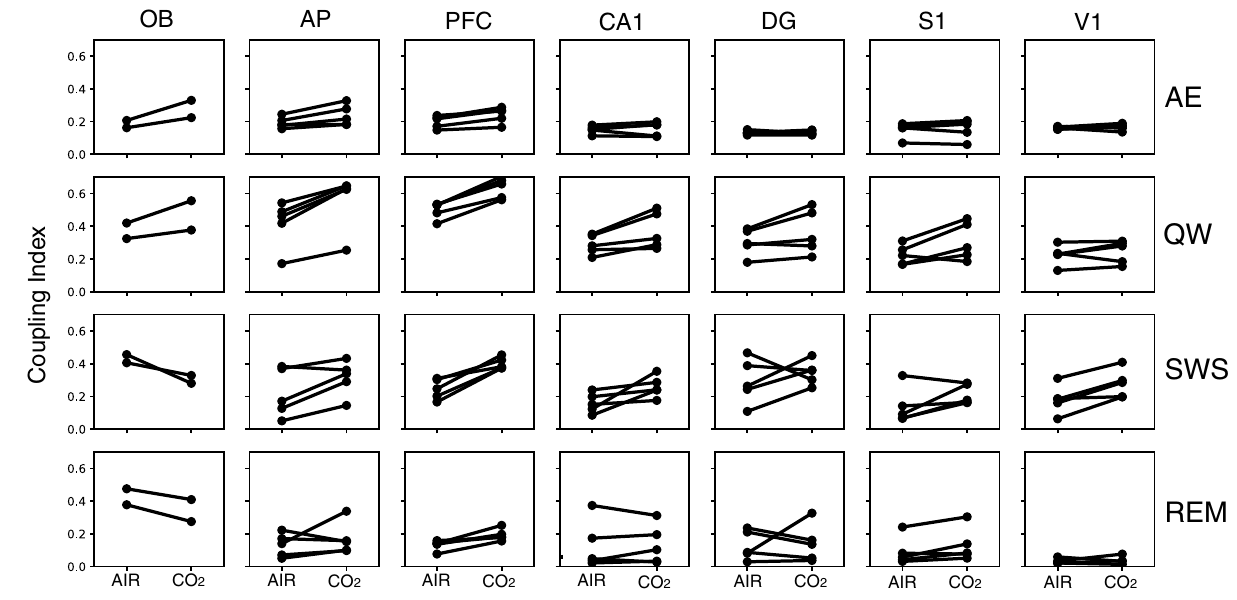
Figure 6. Comparison of respiration-LFP coupling between AIR and CO 2 conditions. For each state (lines), each structure (columns), and each rat (black lines), the coupling index is plotted in AIR and CO 2 conditions. AE active exploration, QW quiet waking, SWS slow-wave sleep, REM rapid eye movements